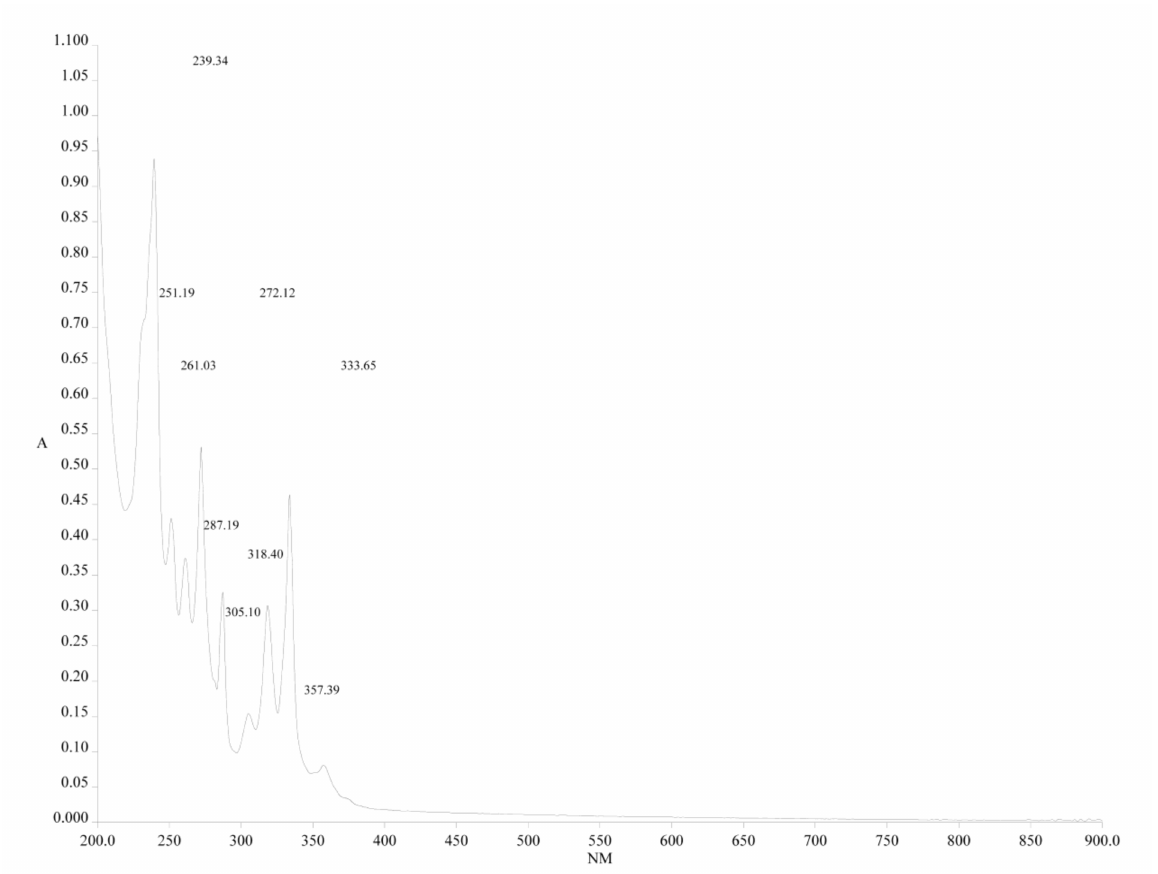
Figure 2. The electronic absorption spectrum of the C 84 -D 2 :22 sample [26,27,39], for determination of molar extinction